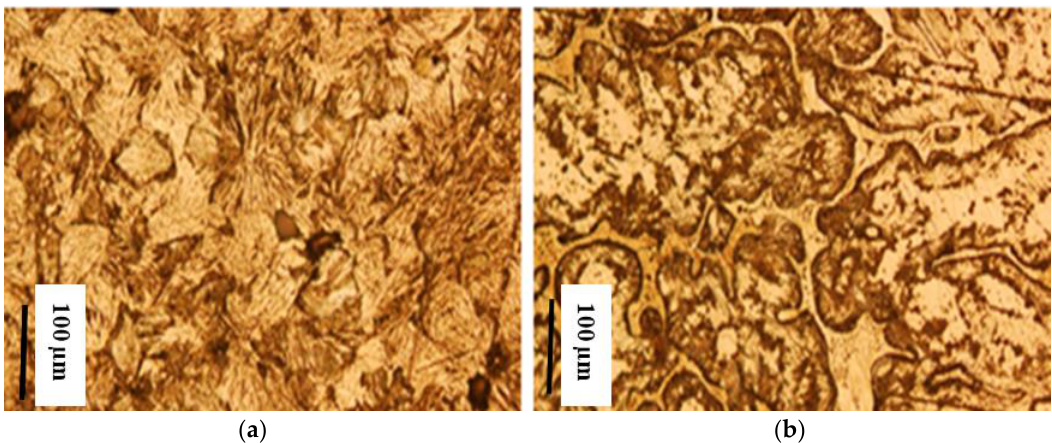
Figure 6. The alloy structure after the annealing performed during: ( a ) Dilatometric (DIL) and ( b ) Differential Scanning Calorimetry (DSC) analysis.